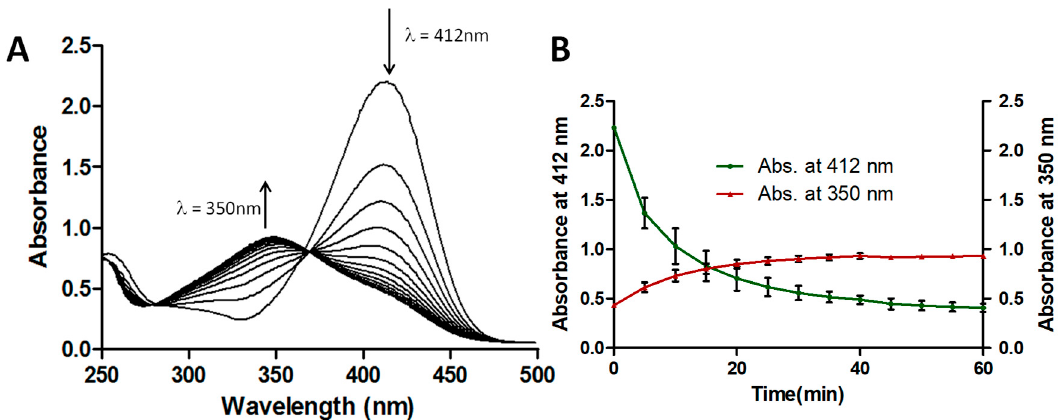
Figure 2. ThT dye degradation by Chloroperoxidase (CPO) + H 2 O 2 . ( A ) UV/Vis absorbance spectra for ThT dye degradation by CPO + H 2 O 2 . Concentration of ThT dye = 25 ppm, pH = 2, concentration of H 2 O 2 = 1 mM, concentration of CPO = 10 nM. The UV/Vis scans were taken every 5 min; ( B ) Changes in absorbances at 412 nm and 350 nm of ThT dye after treatment with CPO + H 2 O 2 . Concentration of ThT dye = 25 ppm, pH = 2, concentration of H 2 O 2 = 1 mM, concentration of CPO = 10 nM. Data shown is the average of triplicate measurements (± SD).